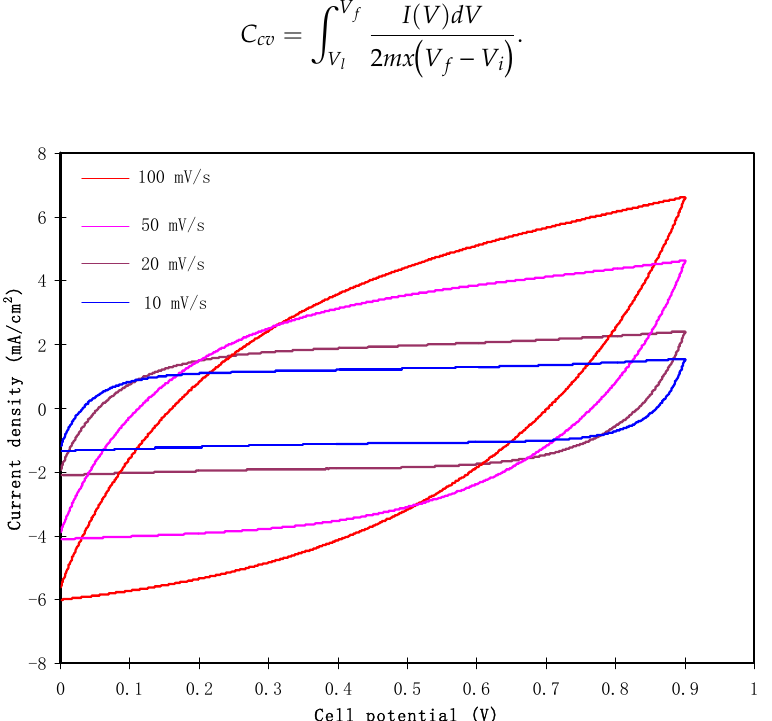
Figure 6. Cyclic Voltammetry (CV) plot of the fabricated EDLC at various scan rates. Here, I(V)dV refers to the CV area plot that is calculated using the Origin 9.0 software by the integration function. x and m are the scan rate and the activated carbon mass, correspondingly. V i is the lower voltage, which is 0 V, and V f is the upper voltage, which is 0.9 V. The values of C cv obtained